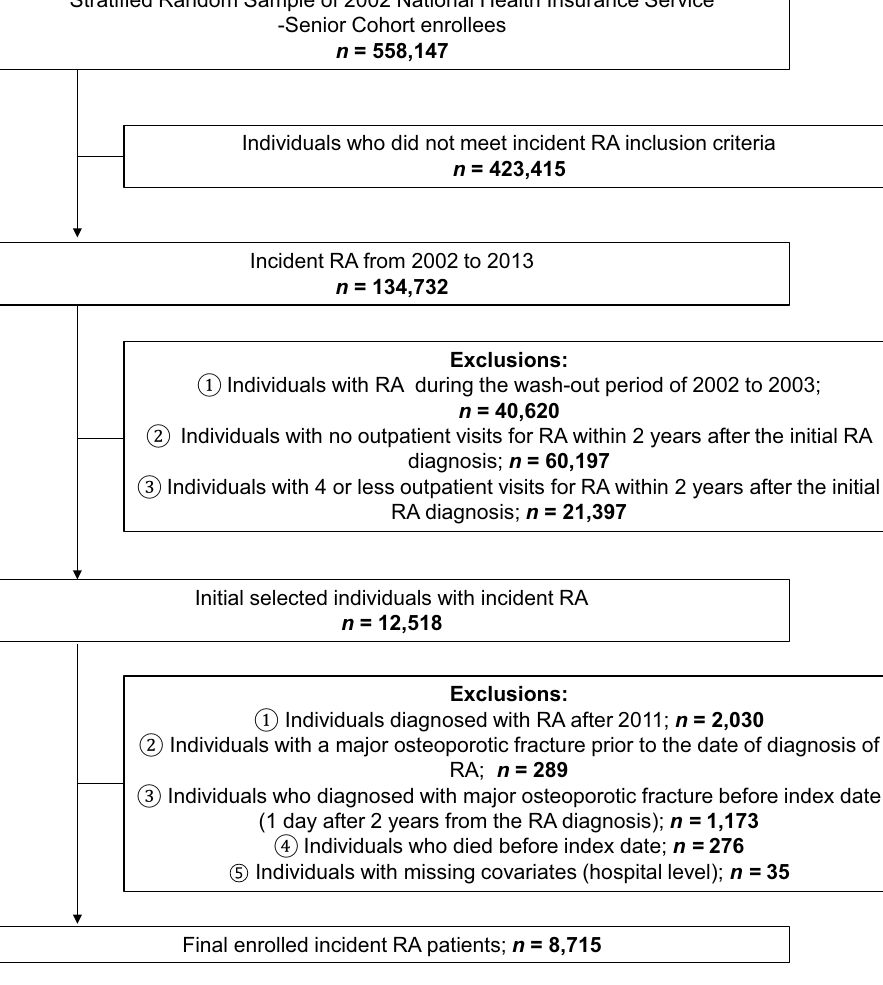
Figure 2. Details of study population. RA, Rheumatoid